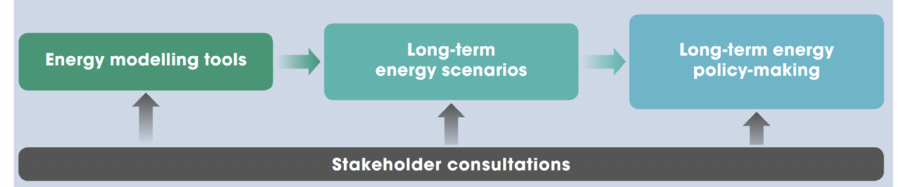
Figure 1. The mental model of IRENA’s Long-Term Energy Scenarios network [57].